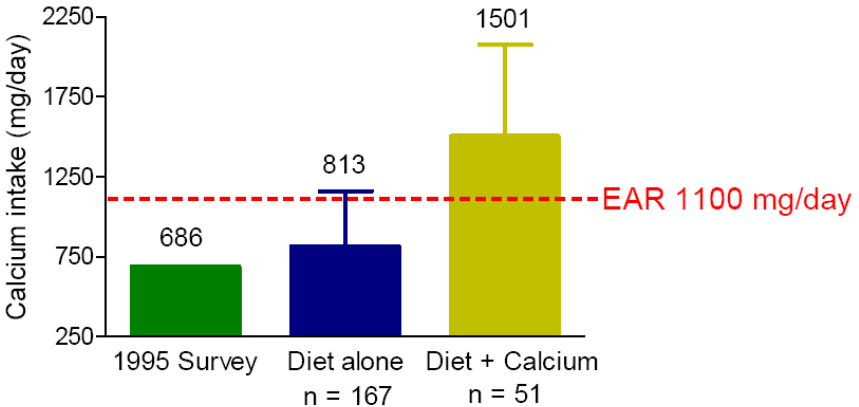
Figure 1. Comparison of calcium intake in the current study participants with intake estimated in the 1995 National Nutrition Survey, with the Estimated Average Requirement